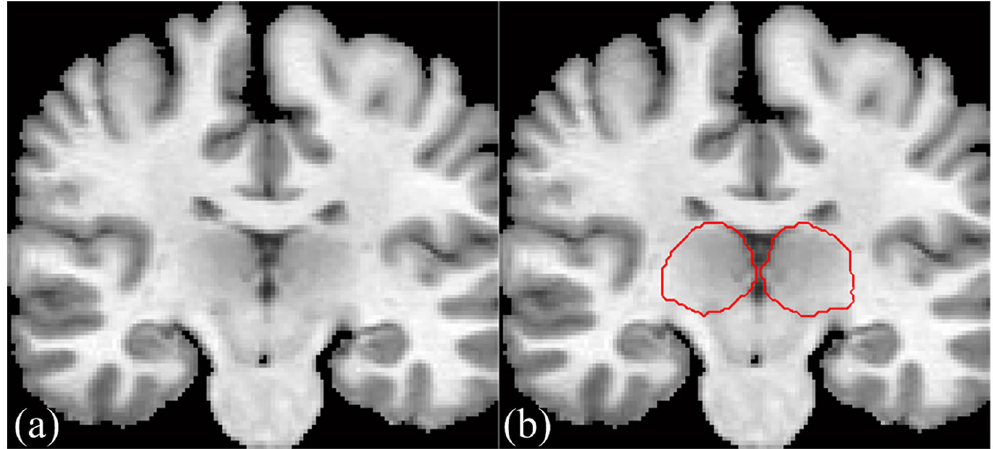
Figure 1. MR T1-weighted image ( a ) an image slice obtained from a 3-D thalamus MR image. ( b ) The manually-delineated thalamus boundary shown by the red contour, superimposed on the original image in ( a